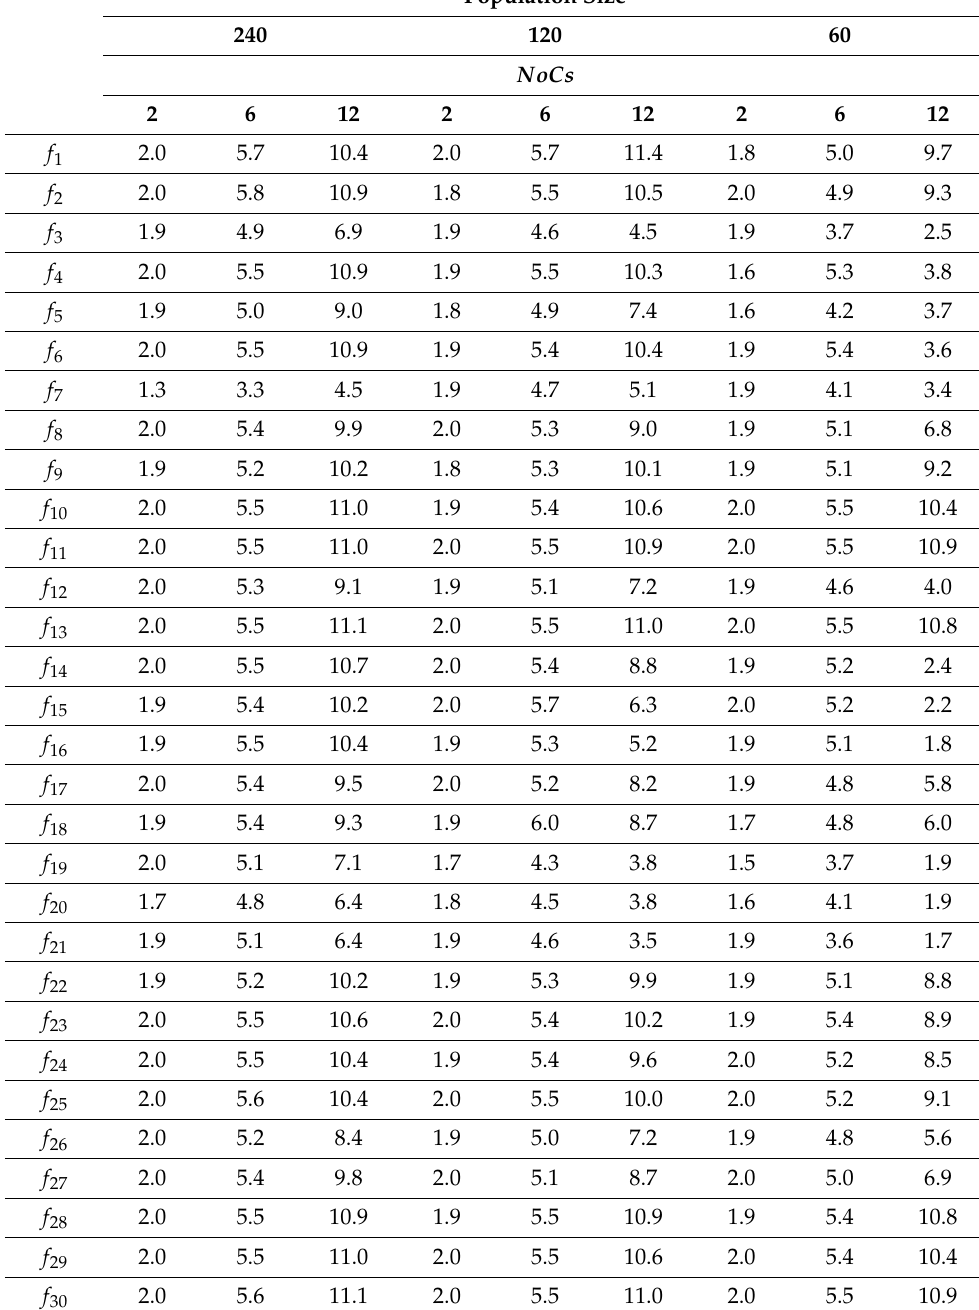
Table 5. Parallel speed-up for parallel data sharing